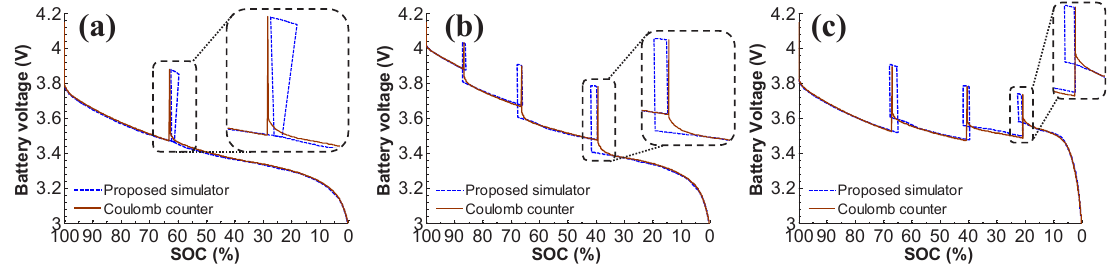
Figure 13. Capacity recovery effects in the P 3 to P 5